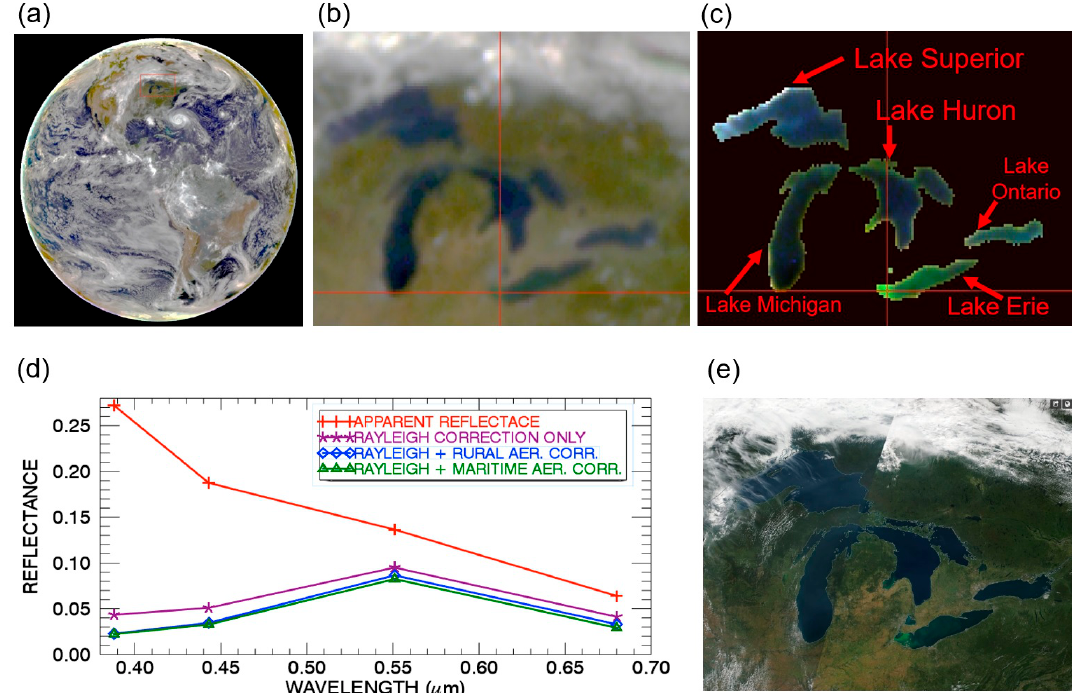
Figure 3. ( a ) The sunlit full disk color image processed from three atmosphere corrected EPIC channel (Red: 680 nm; Green: 551 nm; Blue: 443 nm) images acquired on 24 September 2017 at UTC 1649; ( b ) The portion of color image over Great Lake region; ( c ) The portion of color image of water surfaces over Great Lakes after masking out land and cloud pixels; ( d ) Spectral reflectances as a function of wavelength for one chlorophyll-rich water pixel located in the left part of Lake Erie. ( e ) The 1-km resolution true color Terra MODIS image over the Great Lake area. In ( d ), the line marked with ‘+’ is the top of atmosphere apparent reflectance curve. The lines marked with ‘*’, diamond, and triangle are the retrieved water leaving reflectances for the Rayleigh only, Rayleigh plus rural aerosol model, and Rayleigh plus maritime model corrections, respectively.